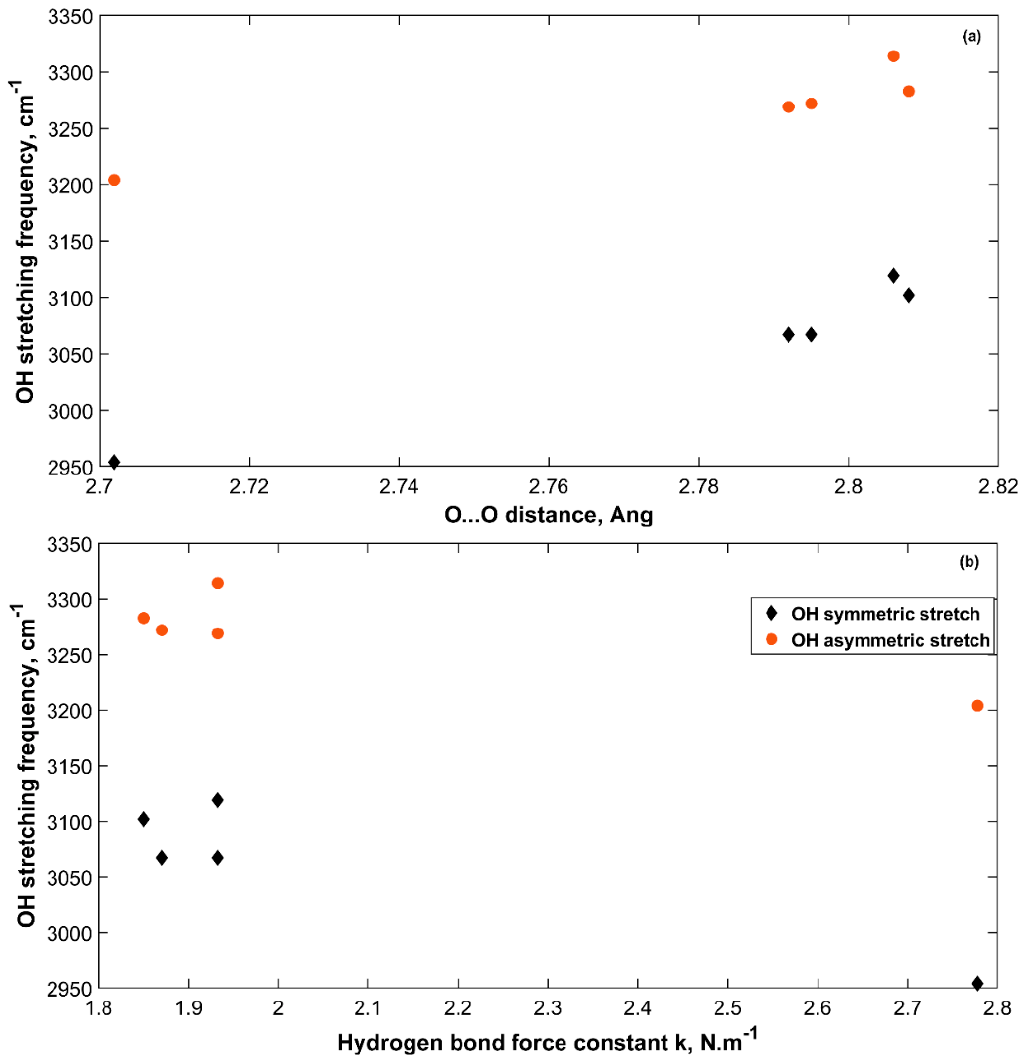
Figure 8. OH stretching frequencies versus O···O distance ( a ) and hydrogen bond force constant ( b ) in sH gas hydrates at zero pressure (0 GPa).